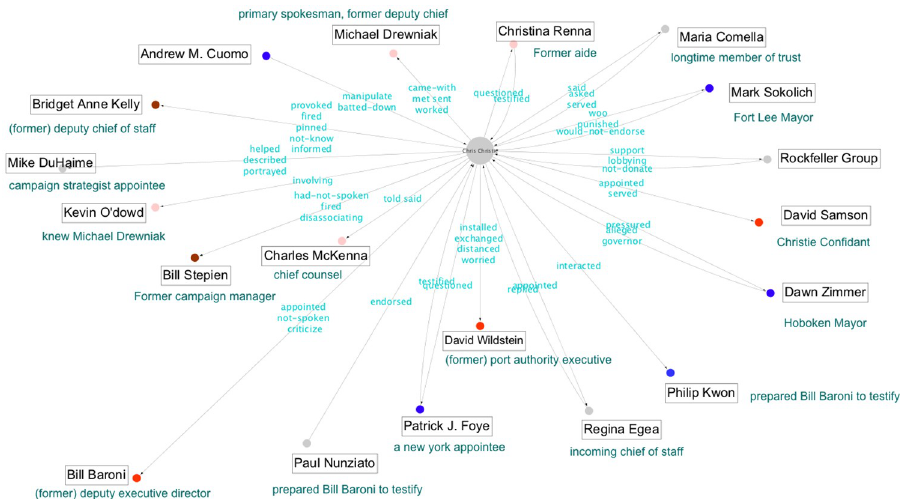
Fig 16. Comparison of relationship labels generated by our automated methodology with the the NY Times Bridgegate graph for Chris Christie. Most significant relationship labels from the “Chris Christie” node to other nodes are displayed here. For each node, we also include one descriptive phrase that was found in an automated manner by our pipeline. These descriptive phrases match very closely the roles portrayed in the NY Times Bridgegate graph. As in other figures, the edge labels only pick the most important verbs for the associated relationship phrase. The rest of the words in the corresponding phrases provide the necessary context for meaningful interpretations of these verbs. For example, the verb“pinned” connecting Christie to Anne Bridgett Kelly, is part of the phrase, “pinned the blame on,” which we extracted from the text.